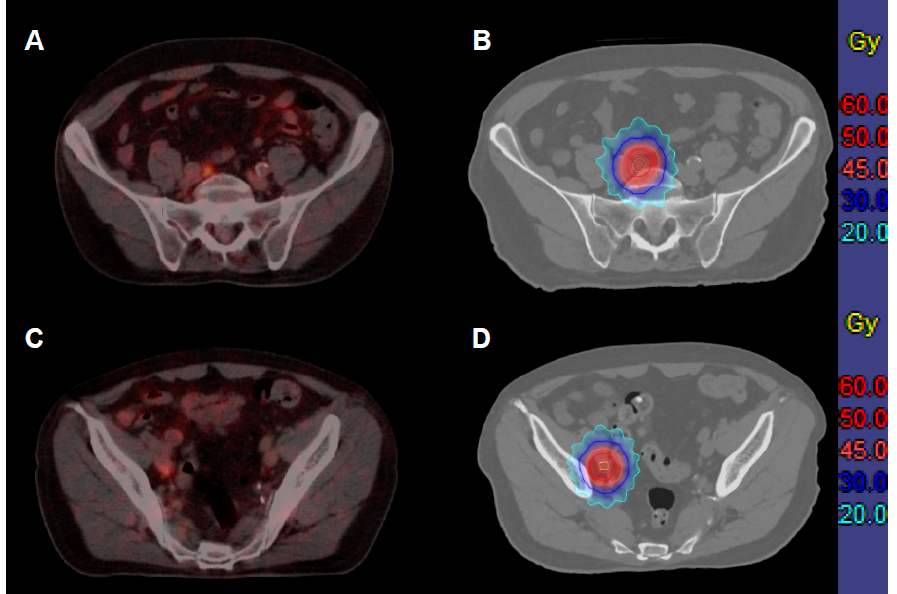
Figure 1. A 75-year-old patient with intermediate-risk prostate cancer (PSA 13.35 ng/mL, Gleason’s score 4 + 3 = 7) received primary radiation therapy (76 Gy in 2 Gy fractions). After three years,